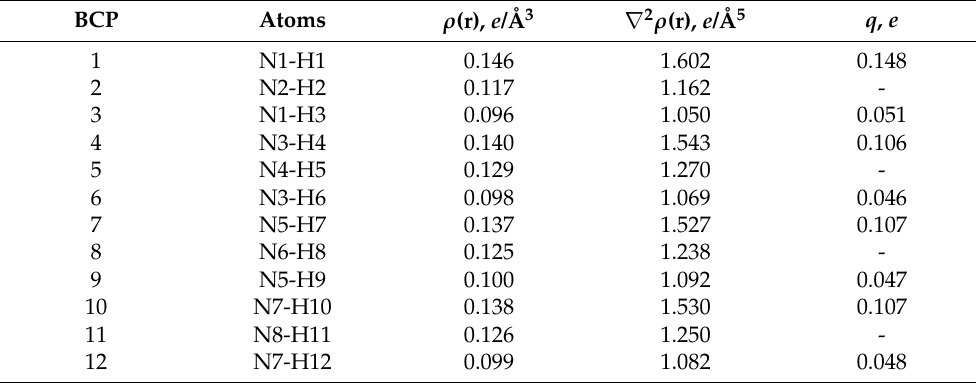
Table 3. Values of ρ ( r ) and ∇ 2 ρ ( r ) at bond critical points characterizing the interaction of four NH 3 molecules with the ZnPc-1py molecule and effective charges q of the corresponding hydrogen atoms of